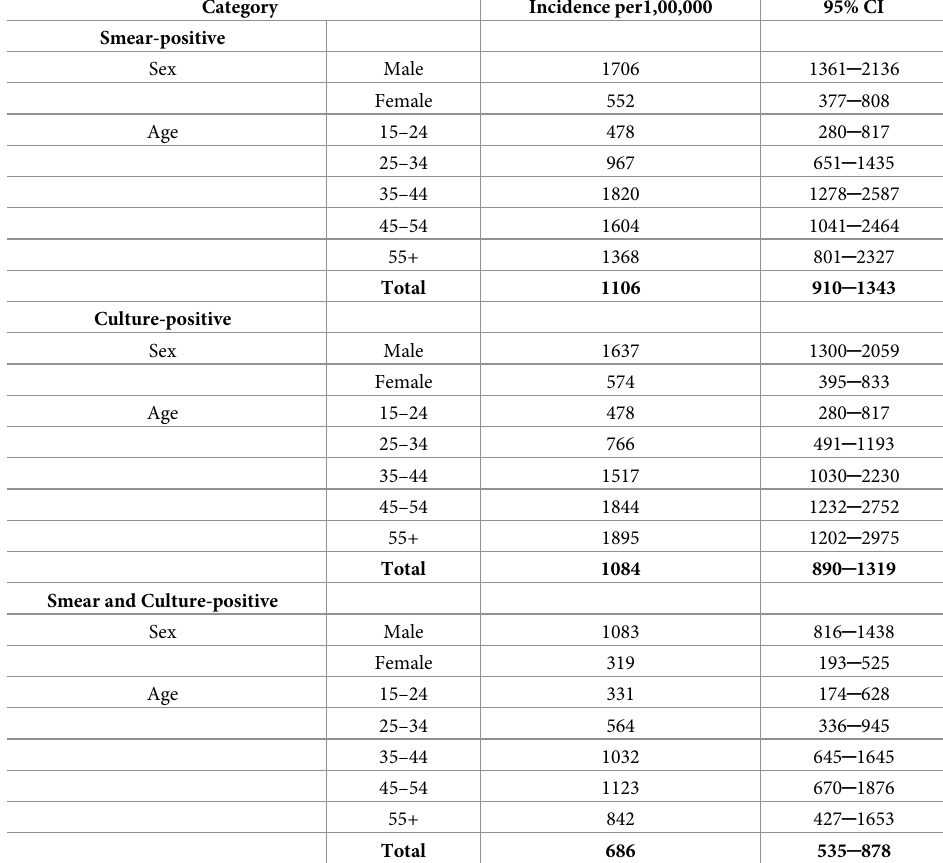
Table 3. Age-sex and category wise incidence of